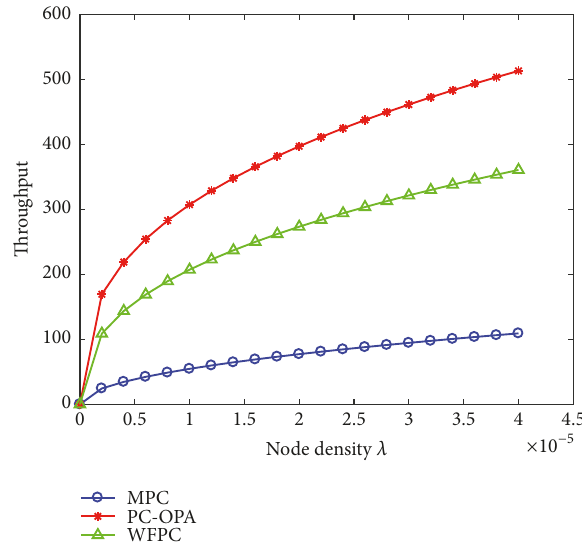
Figure 9: Throughput for different algorithm versus 𝜆 density of